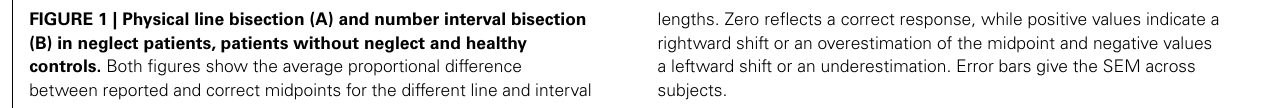
lengths. Zero reflects a correct response, while positive values indicate a rightward shift or an overestimation of the midpoint and negative values a leftward shift or an underestimation. Error bars give the SEM across